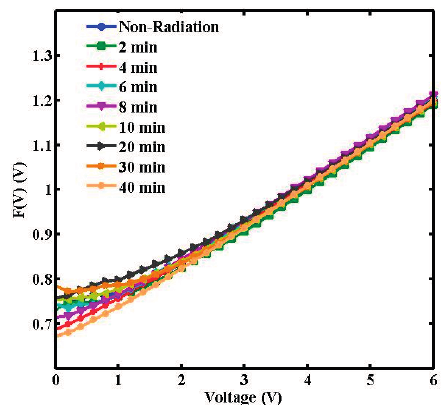
Figure 8. F(V) vs . V plots of the radiated and non-radiated Al/DNA/Si Schottky diodes. In all the methods, values of the barrier heights were observed to converge. The series